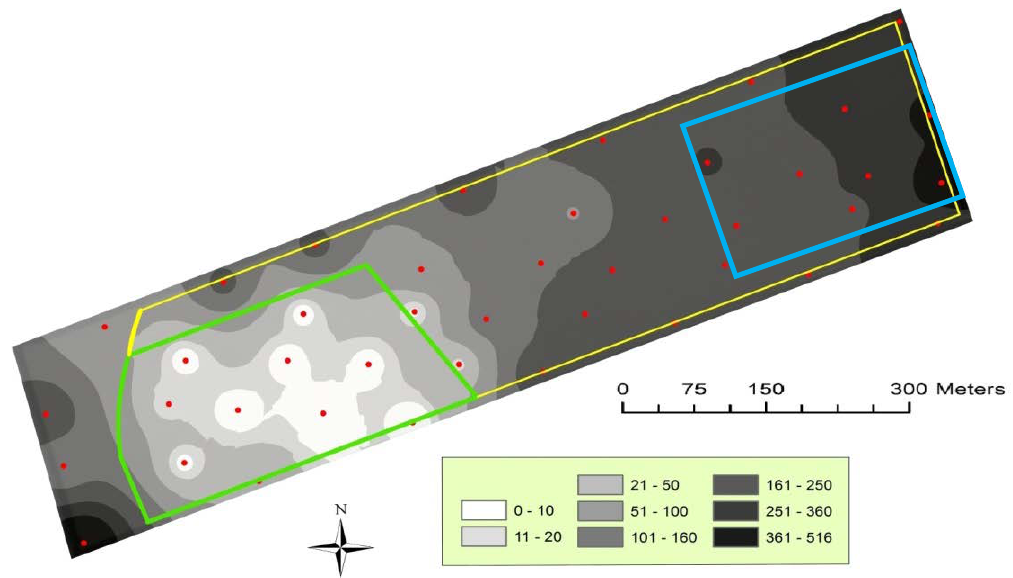
Figure 3. Distribution map of Helicoverpa armigera males in 2012 calculated from the total catch per trap during the sampling period (27 June to 29 August). The mating disruption area (5 ha) is represented by the area on the left; the control area is represented by the rectangle on the right. Sampling points (pheromone baited traps) are represented by dots.